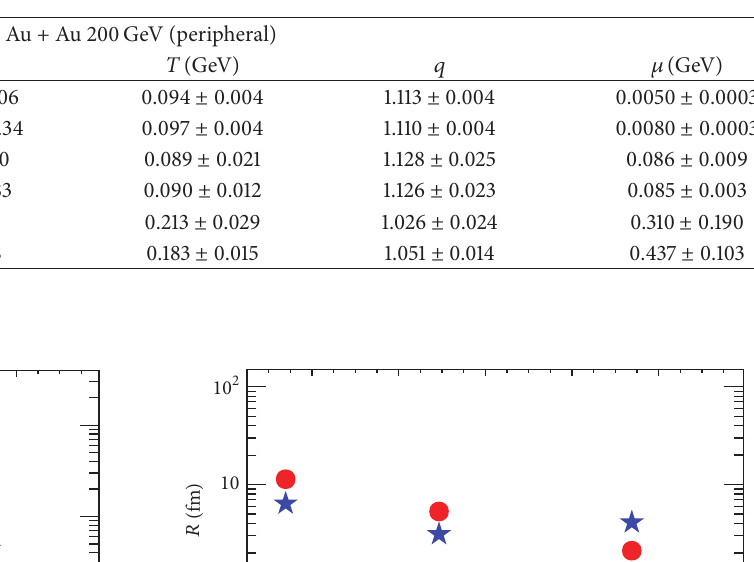
Table 2: 𝜒 2 / ndf and different extracted parameters from Tsallis distribution fit (see (6)) to the 𝑝 𝑇 spectra of 𝜋 ± , 𝐾 ± , 𝑝 , and 𝑝 for most peripheral Au + Au collisions at √𝑠 NN = 200 GeV.